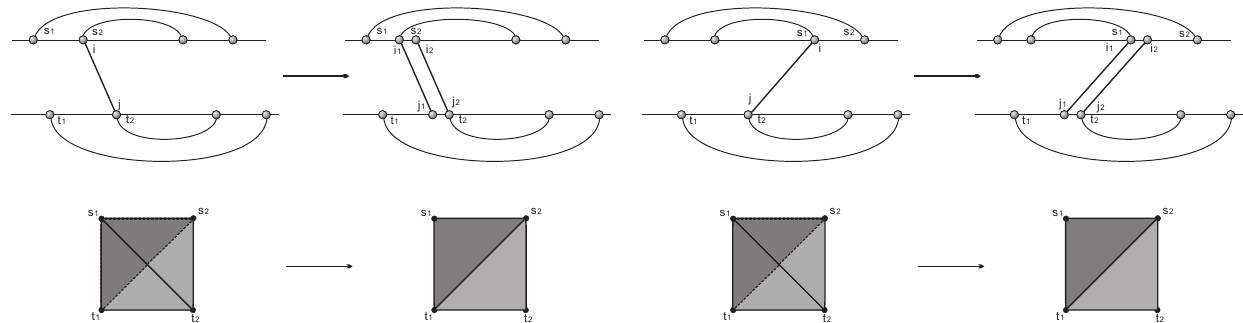
) corresponds to splicing vertices in 1 = { s } and ω = { s } . The vertex i is split into two 1 , s 2 , t 2 1 , t 2 1